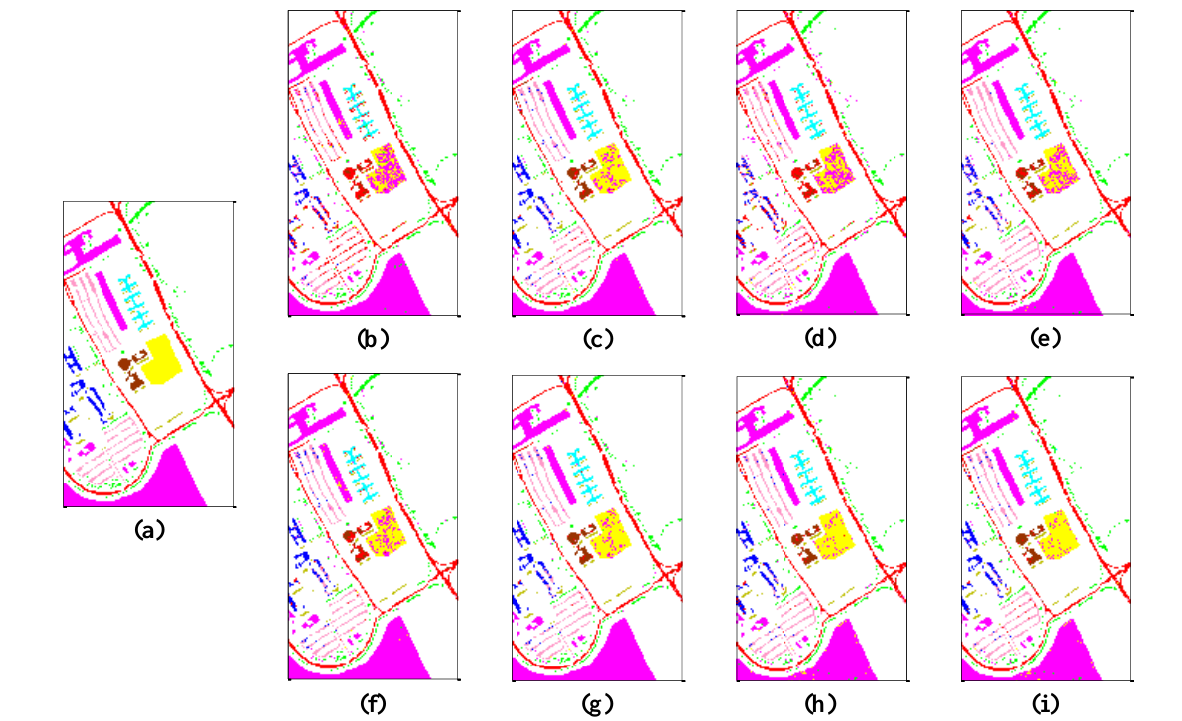
Figure 4. ( a ) Ground truth map and land cover classification maps generated by ( b ) CRC, ( c ) CRT, ( d ) NSC, ( e ) NRS, ( f ) KNCCRC, ( g ) KNCCRT, ( h ) LNNCRC, and ( i ) LNNCRT.